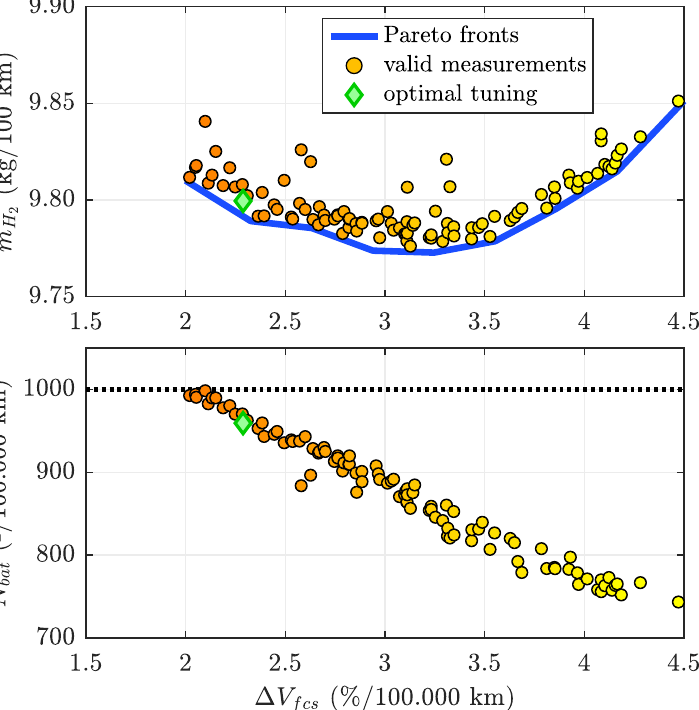
Figure 9. Trade-off between hydrogen consumption, fuel cell voltage degradation, and equivalent battery cycles. The figure shows only the valid measurements at T amb = 20 ◦ C. The green marker corresponds to the selected optimal